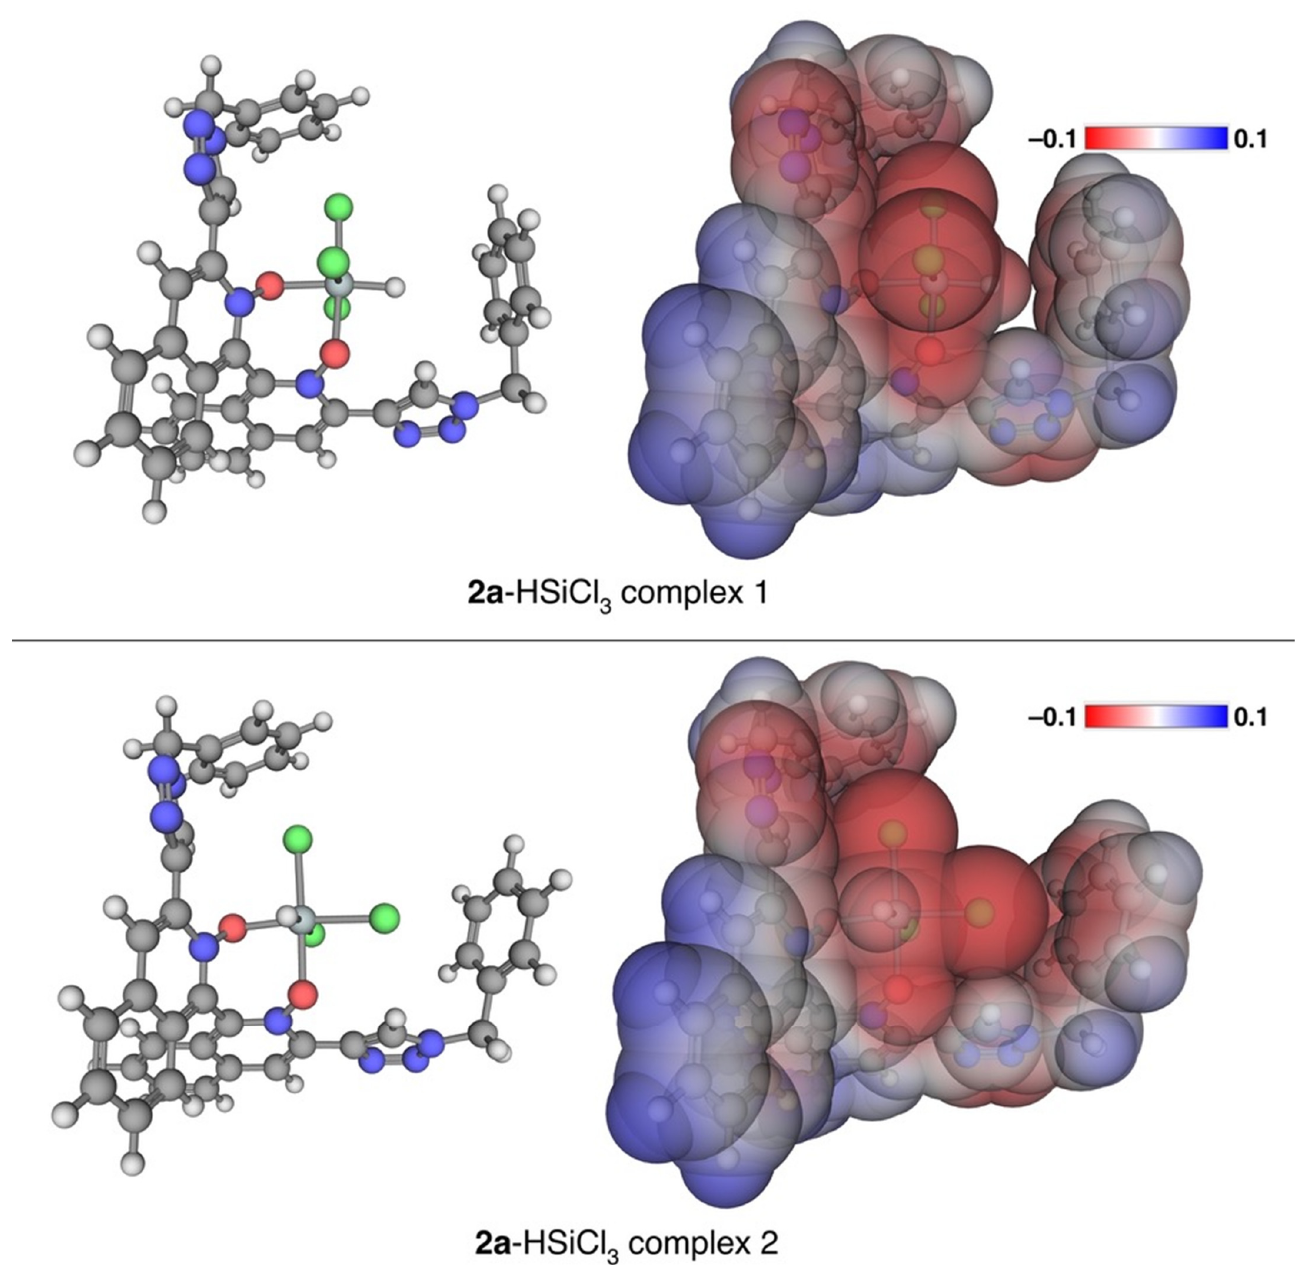
Figure 1. Computed structures of the two lowest energy minima for the 2a -HSiCl 3 complex (i.e., two diastereomeric complexes) calculated with PBEh-3c//C-PCM (DCM). Both are shown with balls-and-sticks ( left ) and space filling ( right ) models. Molecular electrostatic potentials are also shown in the space filling models. Complex 1 ( top ) is 1.91 kcal/mol lower in energy than complex 2 ( bottom ).